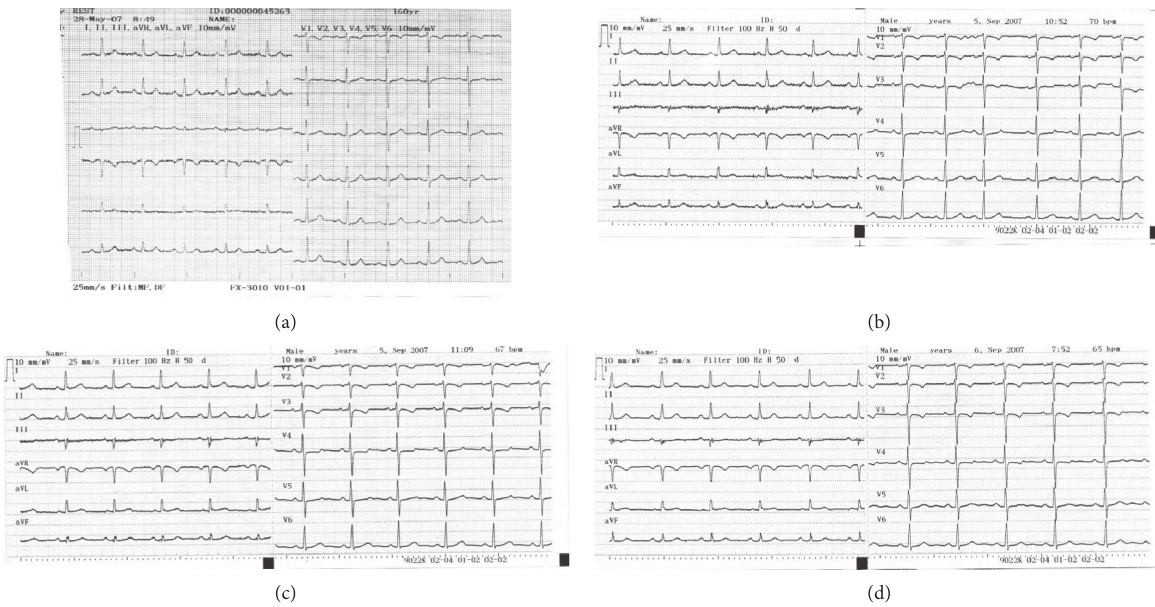
Figure 1: Standard 12-lead ECG recordings: (a) On May 28, 2007, no actual difficulties; (b) at 10: 52 a.m., on September 5, 2007, before the chest pain episode; (c) at 11: 09 a.m., on September 5, 2007, during the chest pain episode; (d) on September 6, 2007, at 7:52 a.m., no difficulties. Note that patient’s sex was erroneously recorded as